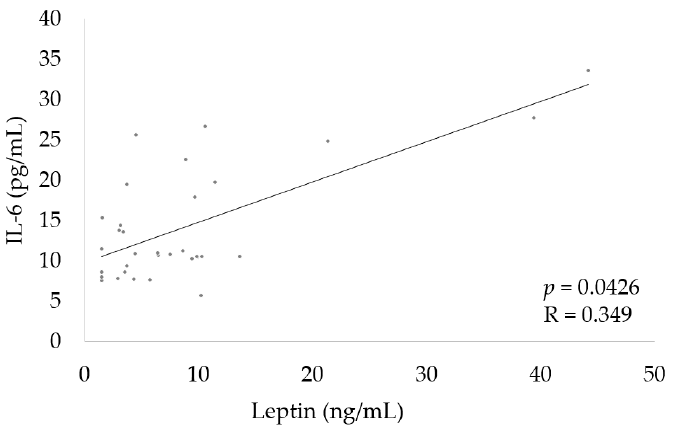
Figure 3. Correlation between IL-6 and